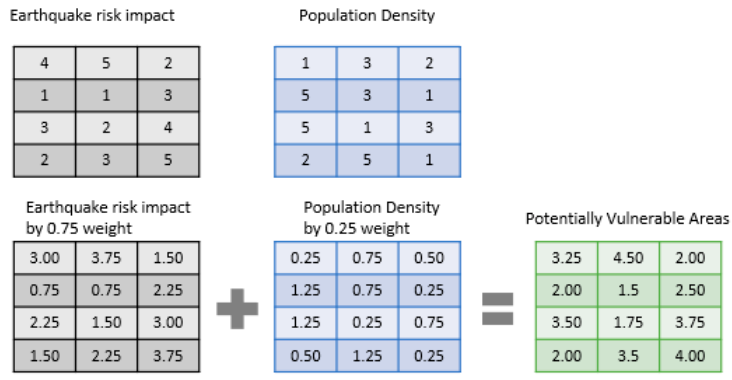
Figure 2. Methodology for the weighted sum.